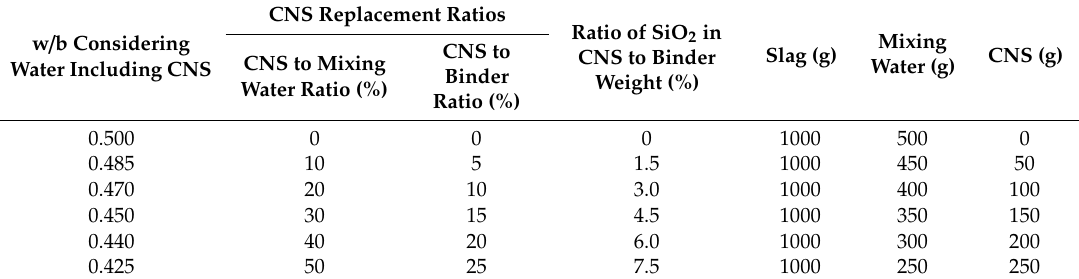
Table 2. Summary of w / b ratios, mixing ratio of CNS and mixture